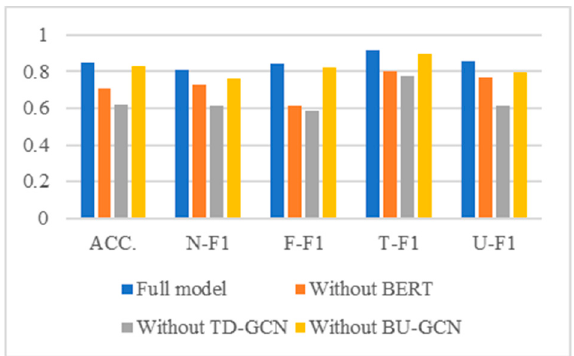
Figure 6. Results of the ablation experiments on Twitter16.